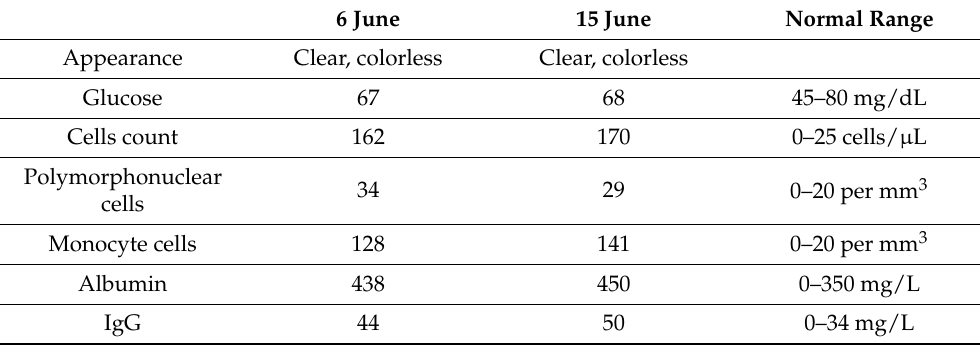
Table 1. Time course of cerebrospinal fluid (CSF) characteristics of the child examined during the study.